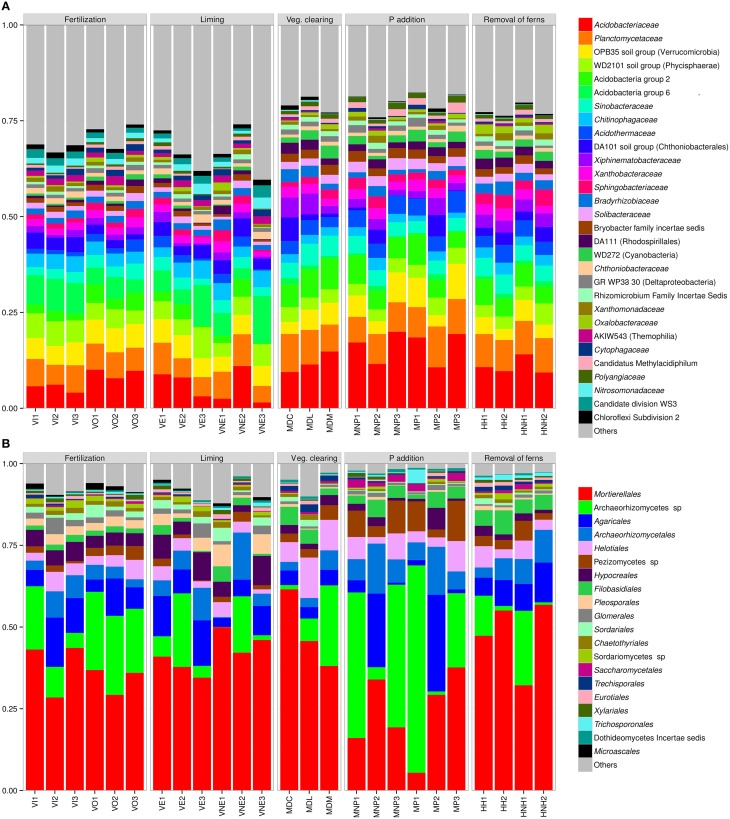
Barplots representing the distribution of the 30 most abundant prokaryotic taxa (A; family level or below) and the 20 most abundant fungal taxa (B; order level or below).